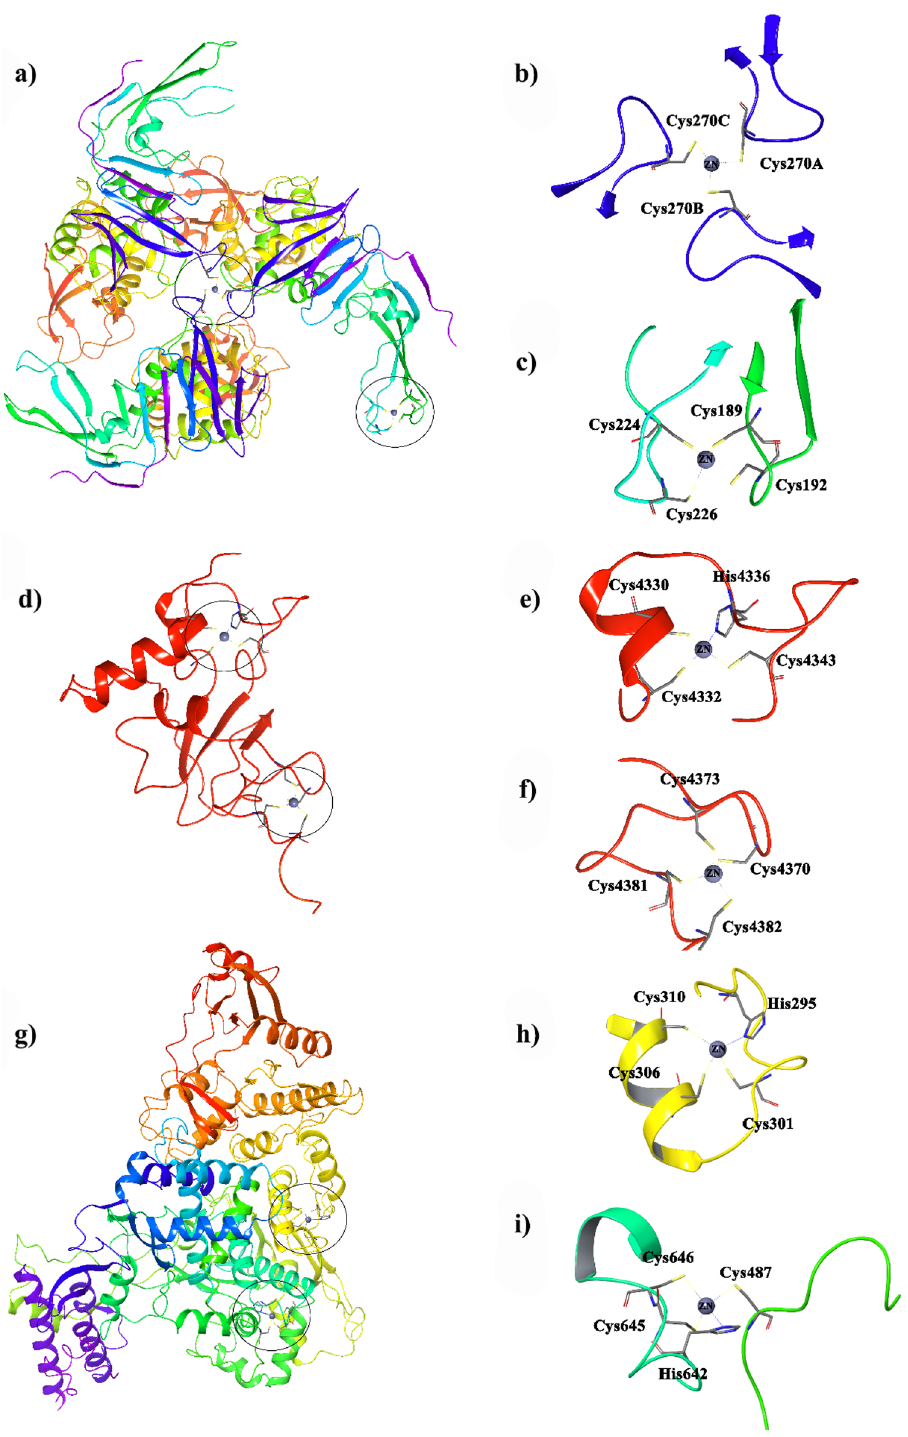
Figure 5. ( a ) SARS-COV-2 nsp3 (papain-like protease; PLpro, PDB ID: 6W9C) and the corresponding zinc motifs in ( b ) , ( c ), and ( d ). SARS-COV-2 nsp10 (PDB ID: 6WKQ) and the corresponding zinc motifs ( e ), ( f ), and ( g ). SARS-COV-2 nsp12 (RNA-dependent RNS polymerase; RdRp, PDB ID: 7BTF) and the corresponding zinc motifs ( h ) and ( i